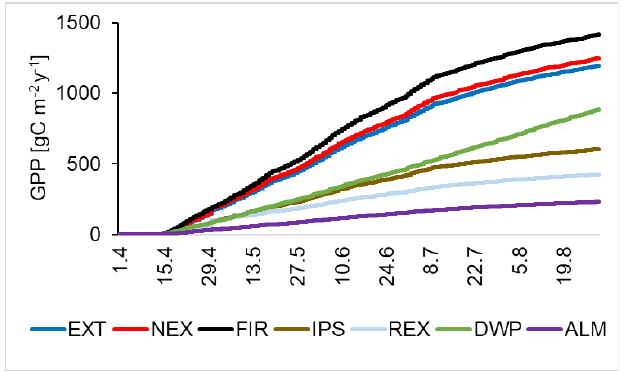
Figure 5. Seasonal (April 1 – August 31) sum of GPP for studied ecosystem types, where EXT —